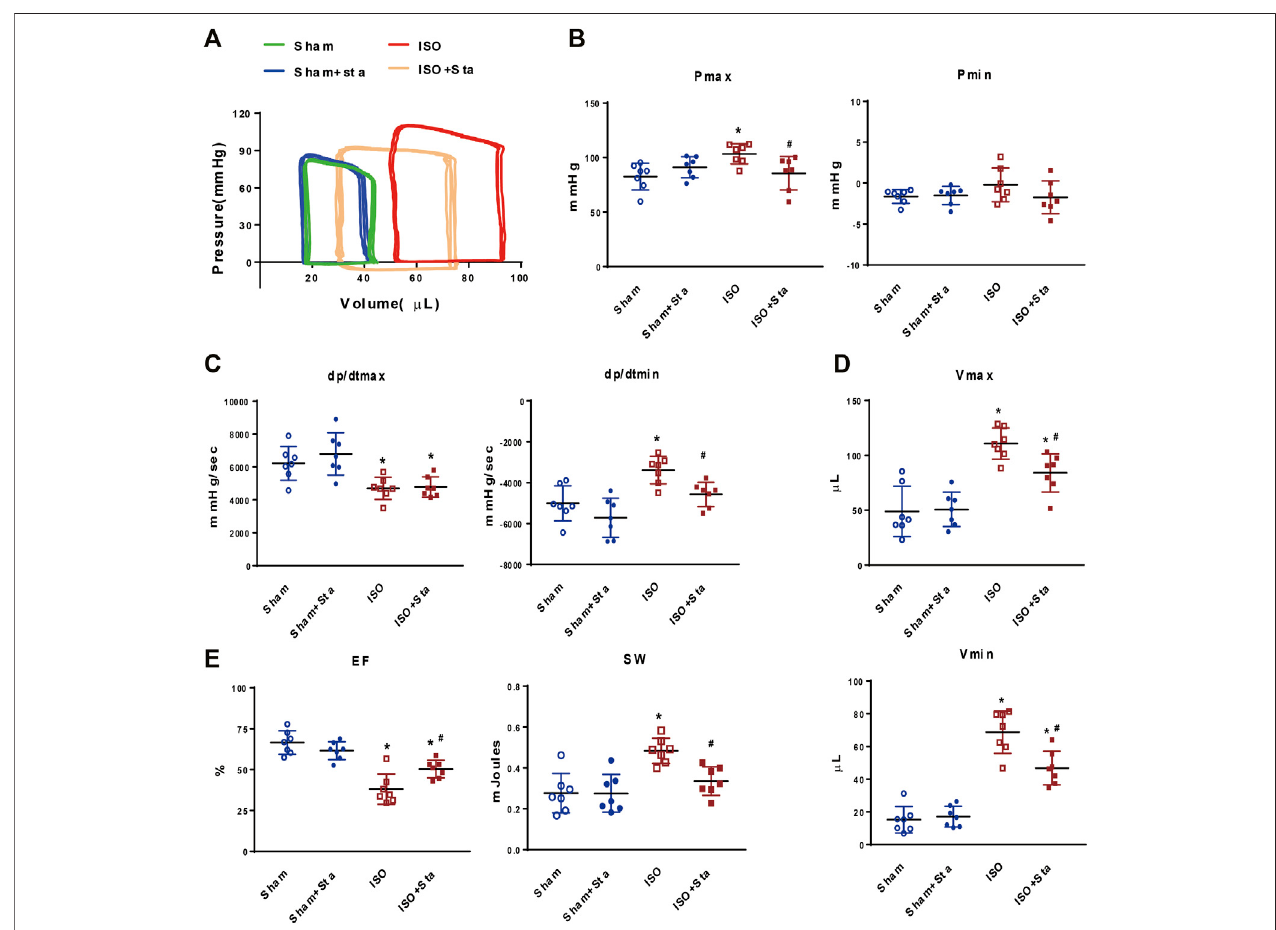
FIGURE 2 | Stachydrine hydrochloride modulates hemodynamic parameters during chronic β 1AR activation in vivo . (A) Representative images of hemodynamic parameters. (B) Quanti fi cationofPmaxandPmin( n =7miceperexperimental group). (C) Quanti fi cationofdP/dtmaxanddP/dtmin( n =7miceperexperimental group). (D) Quanti fi cationofVmaxandVmin( n =7miceperexperimentalgroup). (E) Quanti fi cationofEFandSW( n =7miceperexperimentalgroup).Hemodynamicparameters were recorded and measured at 2 weeks after surgery. The data are expressed as mean ± standard error of mean, * p < 0.05 versus Sham; # p < 0.05 versus ISO. ISO, isoproterenol; Sta, stachydrine hydrochloride; Pmax, maximum left ventricular pressure; Pmin, minimum left ventricular pressure; dP/dtmax, peak rate of pressure rise; dP/dtmin, peak rate of pressure decline; Vmax, max of volume; Vmin, min of volume; EF: left ventricle ejection fraction; SW, stroke work.